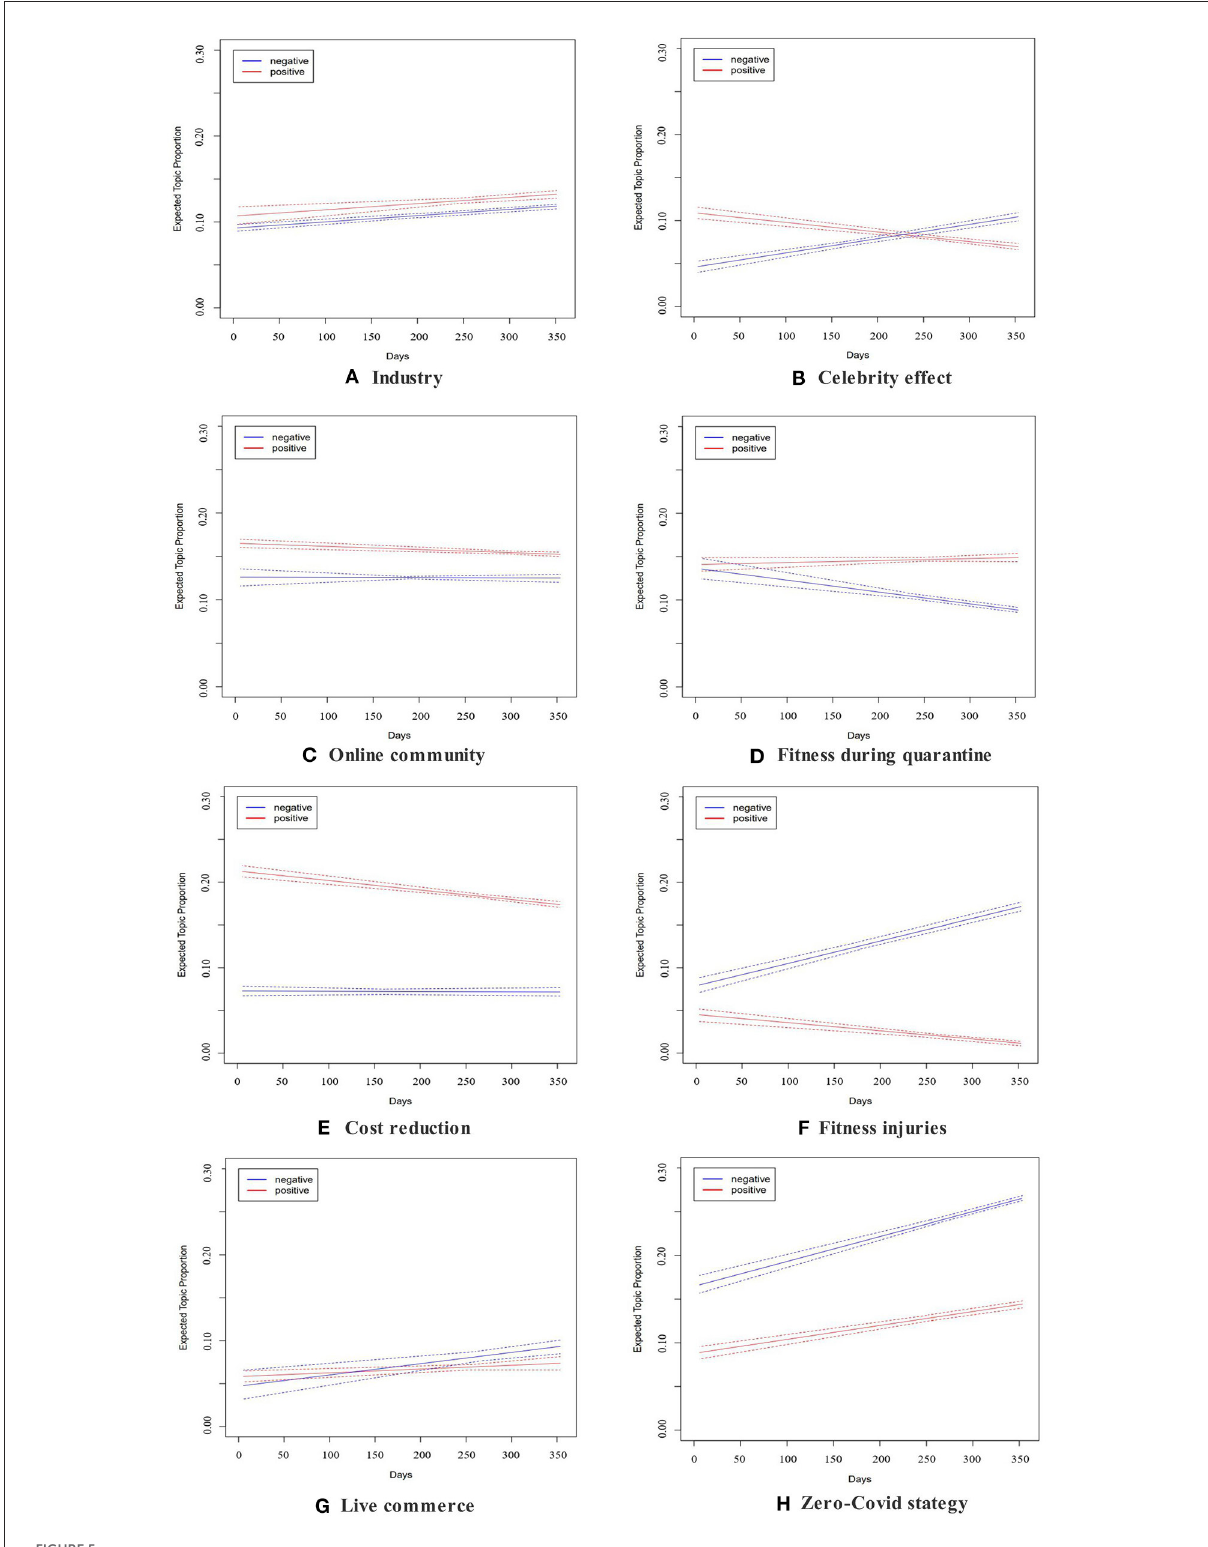
FIGURE5 (A–H) Moderating effects of